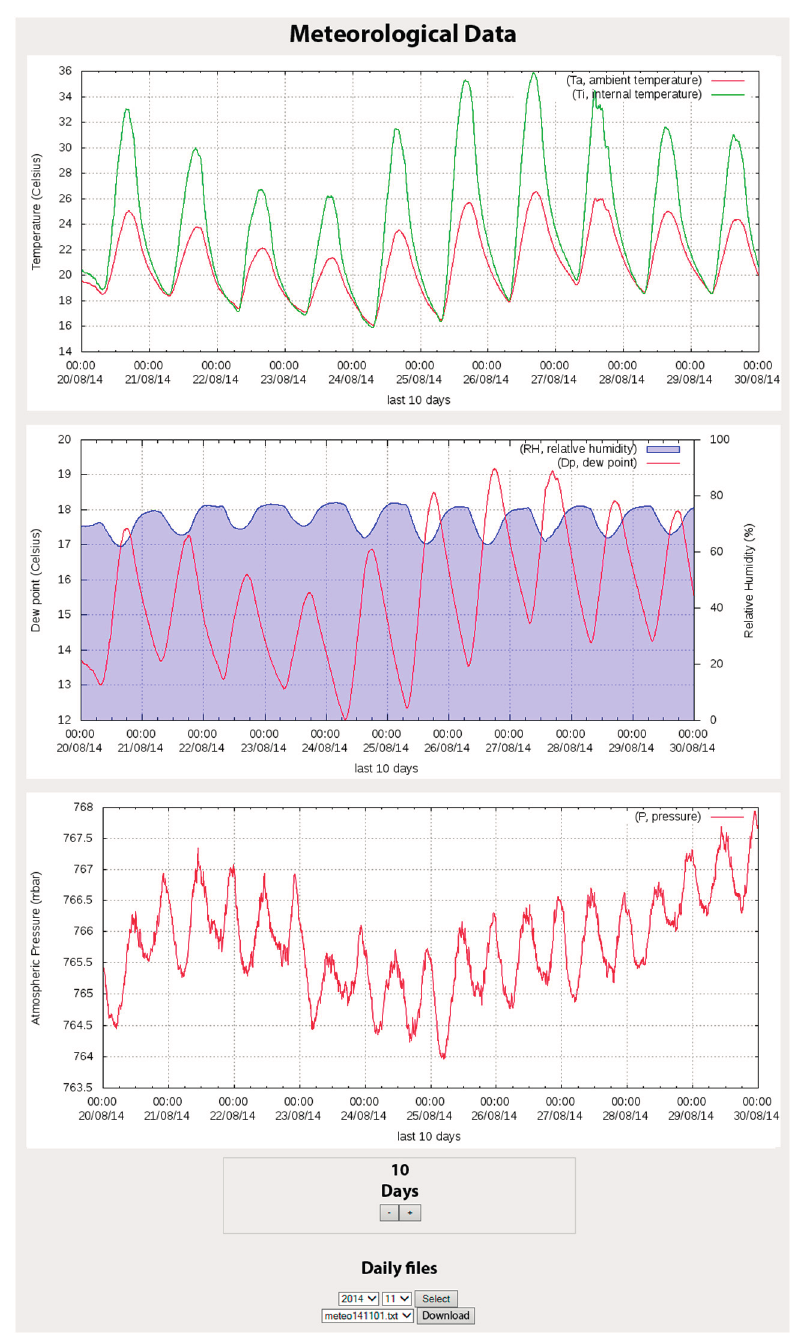
Figure 4. Image captured from the website corresponding to the meteorological data of the gravimeter system. Top: the ambient and internal temperature; middle: the relative humidity and dew point; bottom: the pressure. A 10-day period is